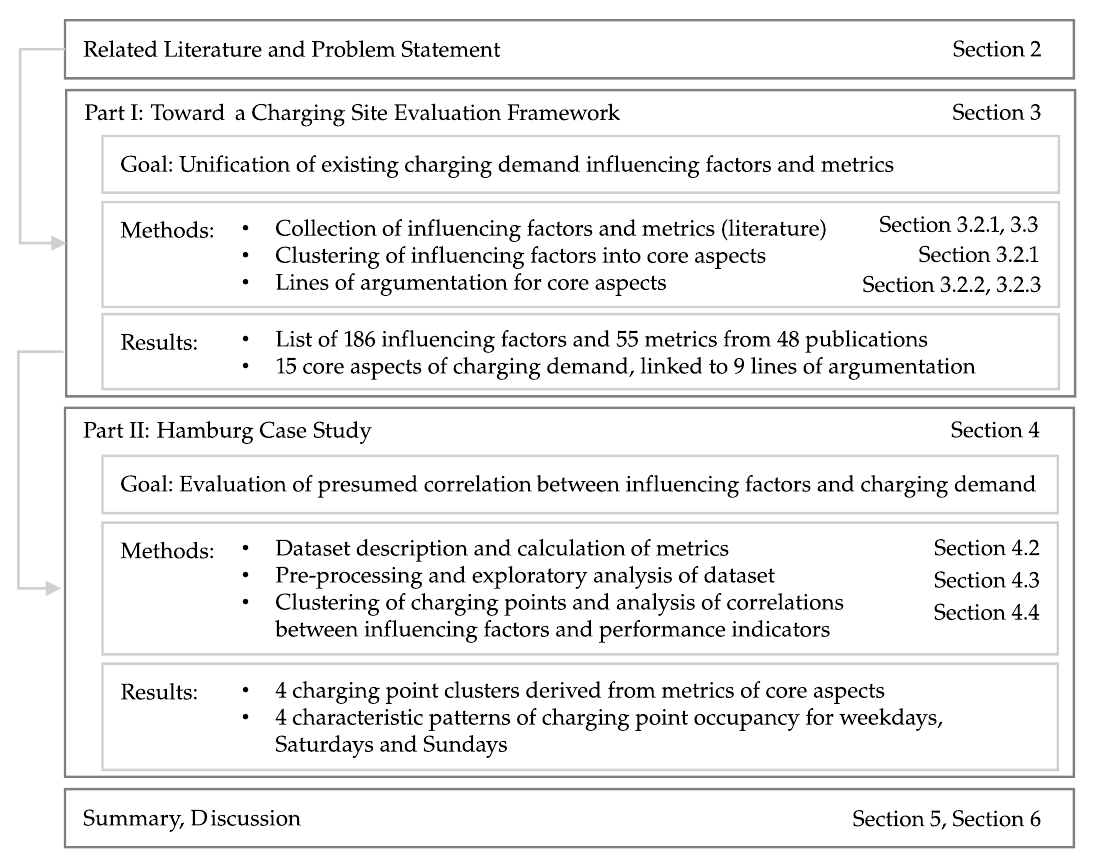
Figure 1. Structure of this article.